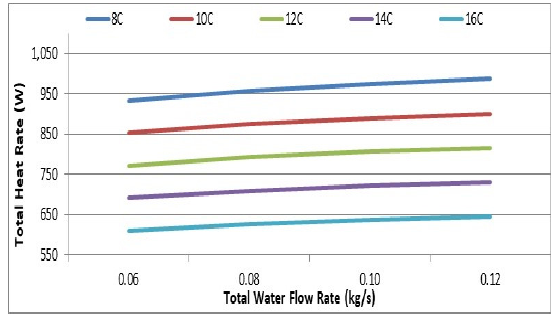
Fig. 11. The total heat rate of terminal units at 8, 10, 12, 14 and 16 °C water supply temperature and valve opening: Valve 1=100%, Valve 2=100% and Valve